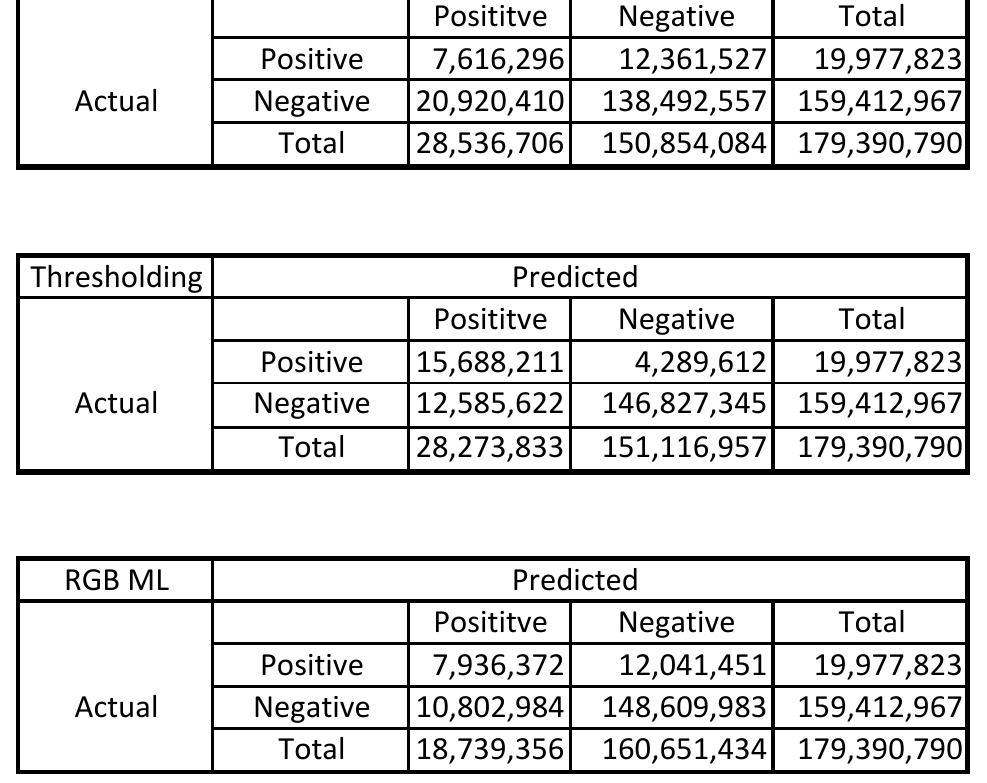
Figure 14. Confusion matrices for ( a ) DeepLabv3+ analysis compared with Sentinel-2 NDWI analysis; ( b ) thresholding analysis compared with Sentinel-2 NDWI analysis; and ( c ) false color RGB ML analysis compared with Sentinel-2 NDWI analysis. In each, the top left box shows true positives (tp), the top right shows false positives (fp), bottom left shows false negatives (fn) and bottom right shows true negatives (tn) for each comparison.